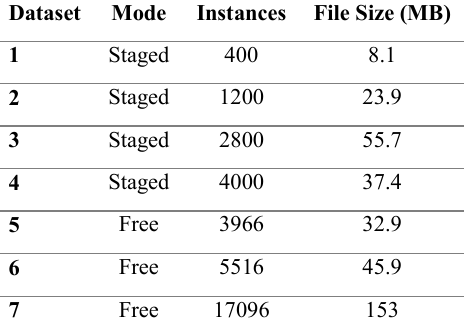
Table 1. Overview of the seven